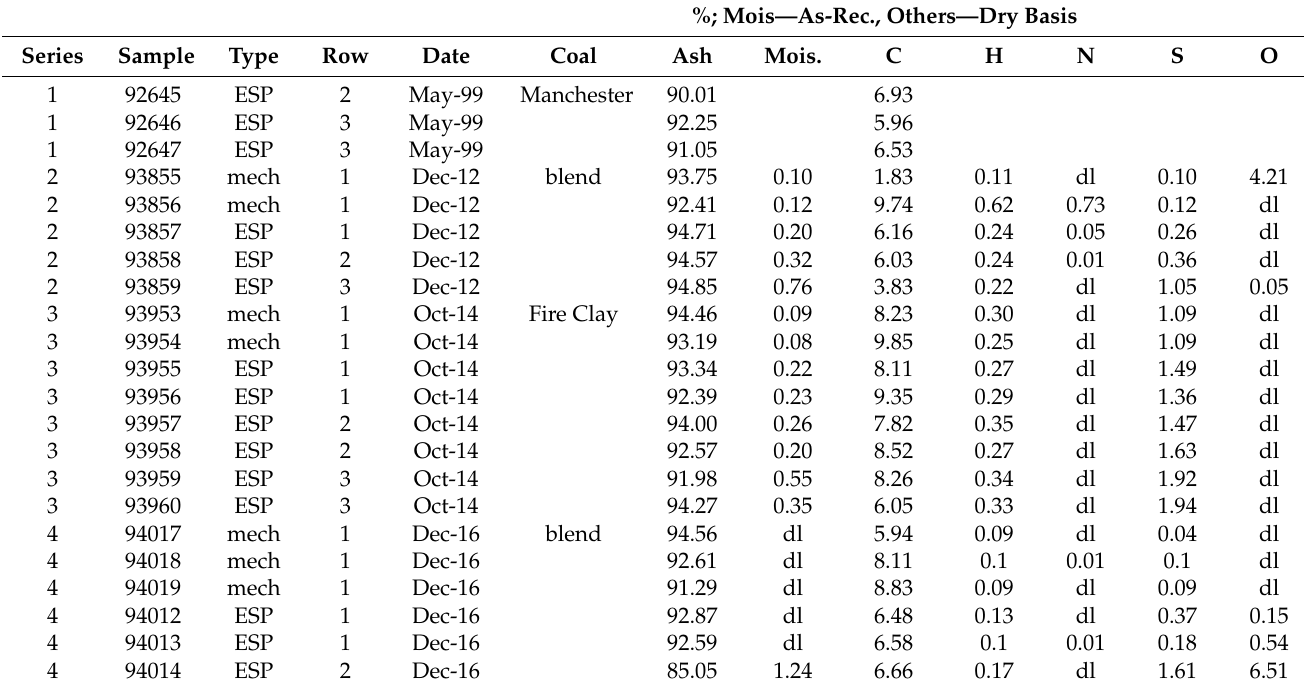
Table 1. Series, sample type, collection date, coal seam, ultimate analysis. dl—detection limit. %; Mois—As-Rec., Others—Dry Basis